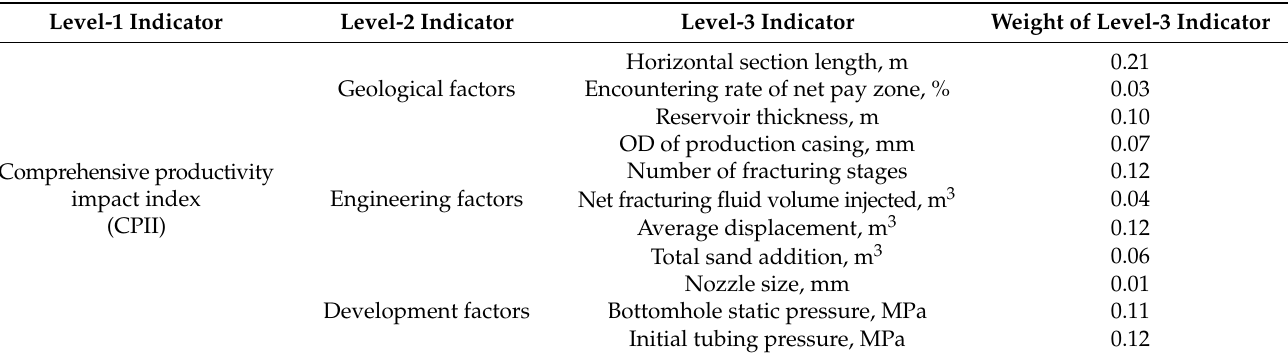
Table 6. Weights of CPII indicators for fractured horizontal